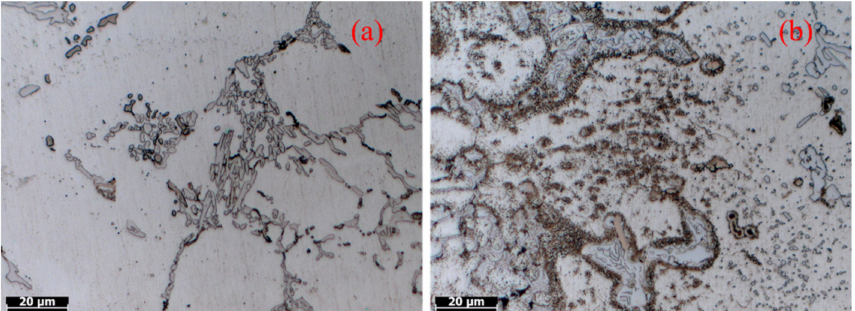
Figure 8. Optical microscopy images of melted carbides in the fusion zone for ( a ) as-cast alloy and ( b ) aged alloy.